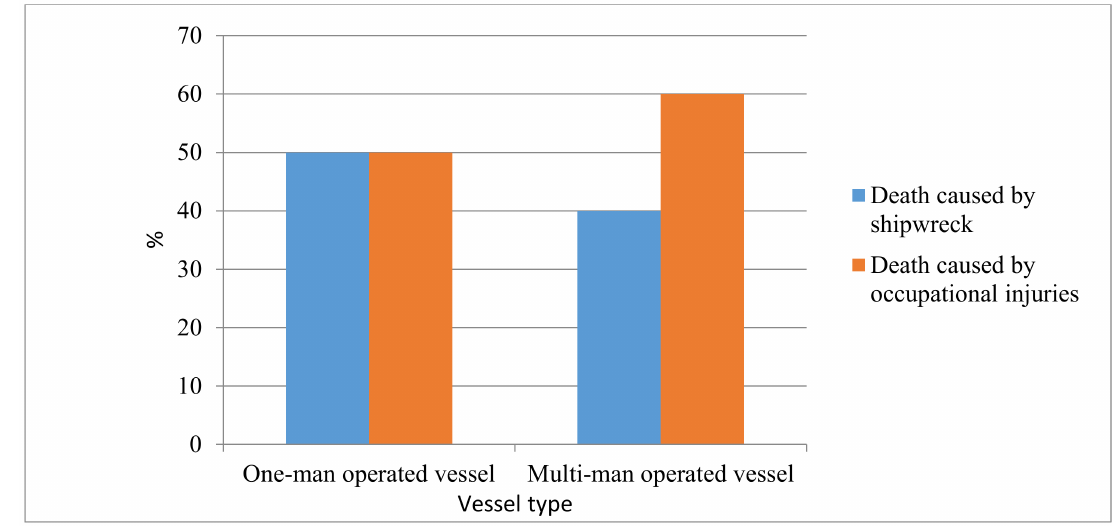
Figure 5. Distribution of deaths caused by work-related injuries and shipwrecks depending on crew size of the vessel in the period 1998–2012.